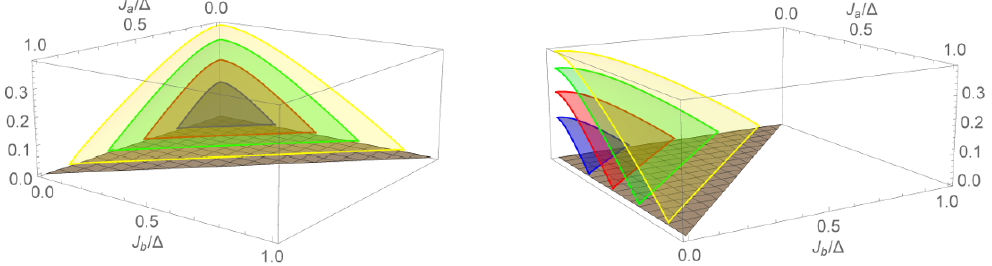
holes with vanishing U(1) charge, so the gray surface is S BH = 0, where our bound implies O (1) degeneracy of states.